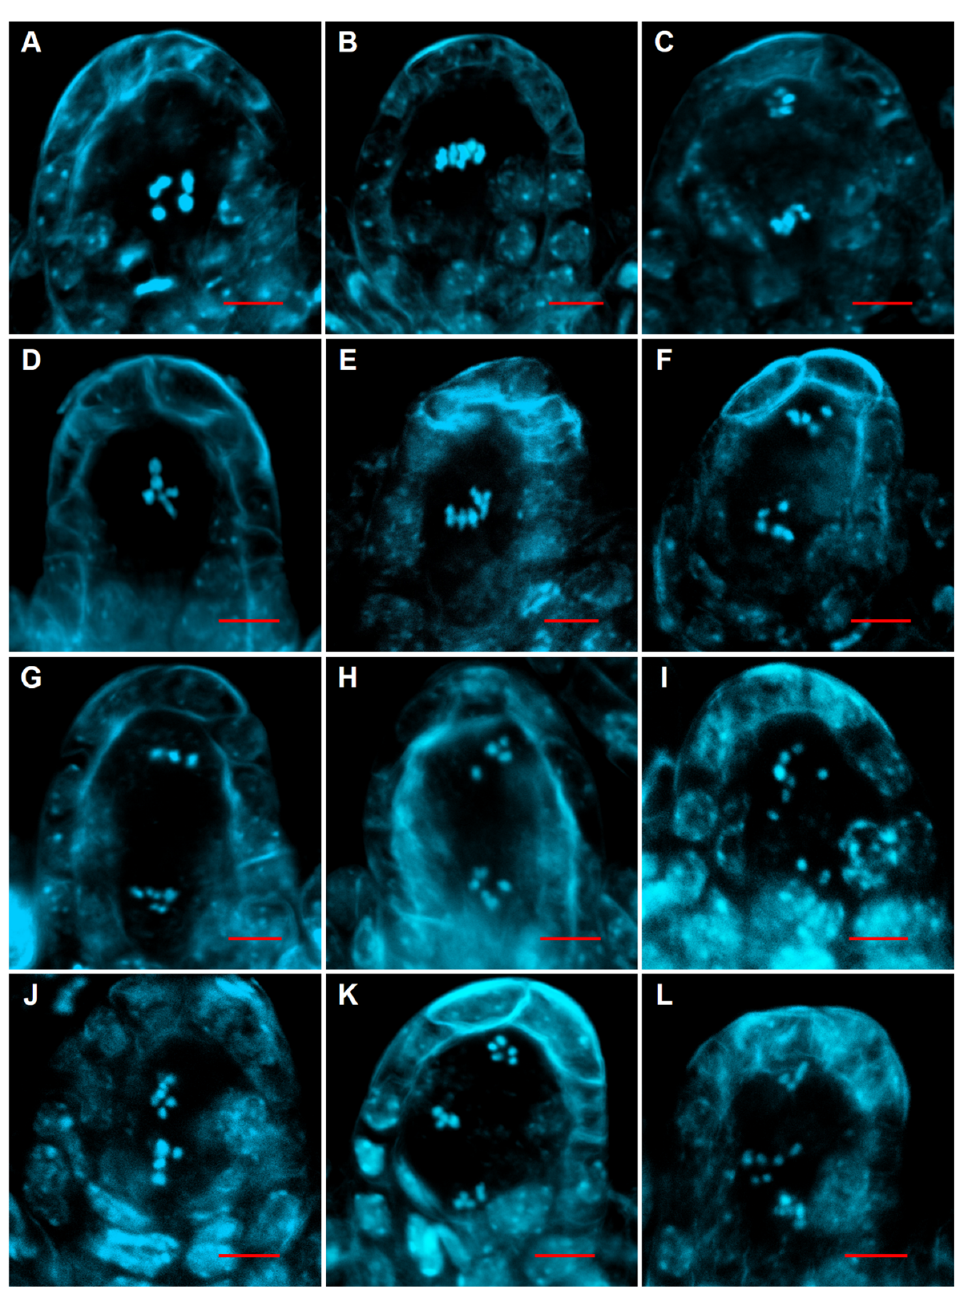
Figure 3. Female meiosis in the WT and ubc22 mutant. The ovules of the WT ( A – C,K ) and diploid ubc22-1 mutant ( D – J,L ) were dissected, processed and stained with DAPI and Calcofluor White. Meiotic chromosomes were observed with a confocal laser scanning microscope. ( A , D ) Prophase I (diakinesis) in the WT ( A ) and mutant ( D ), showing five brightly condensed bivalents. ( B , E ) The five bivalents were organized on the metaphase I plate in the WT ( B ) and mutant ( E ). ( C , F ) Telophase I in the WT ( C ) and mutant ( F ), showing sets of evenly segregated chromosomes located at the two poles. ( G ) Uneven segregation of homologous chromosomes with three chromosomes on the top and seven at the bottom. ( H ) Uneven segregation of homologous chromosomes with four on the top. ( I ) Uneven segregation of homologous chromosomes with seven on the top. ( J ) Uneven segregation of homologous chromosomes with six on the top. ( K ) Meiosis II in WT. ( L ) Meiosis II in the mutant, showing uneven chromosome segregation. Scale bars = 5 μ m.